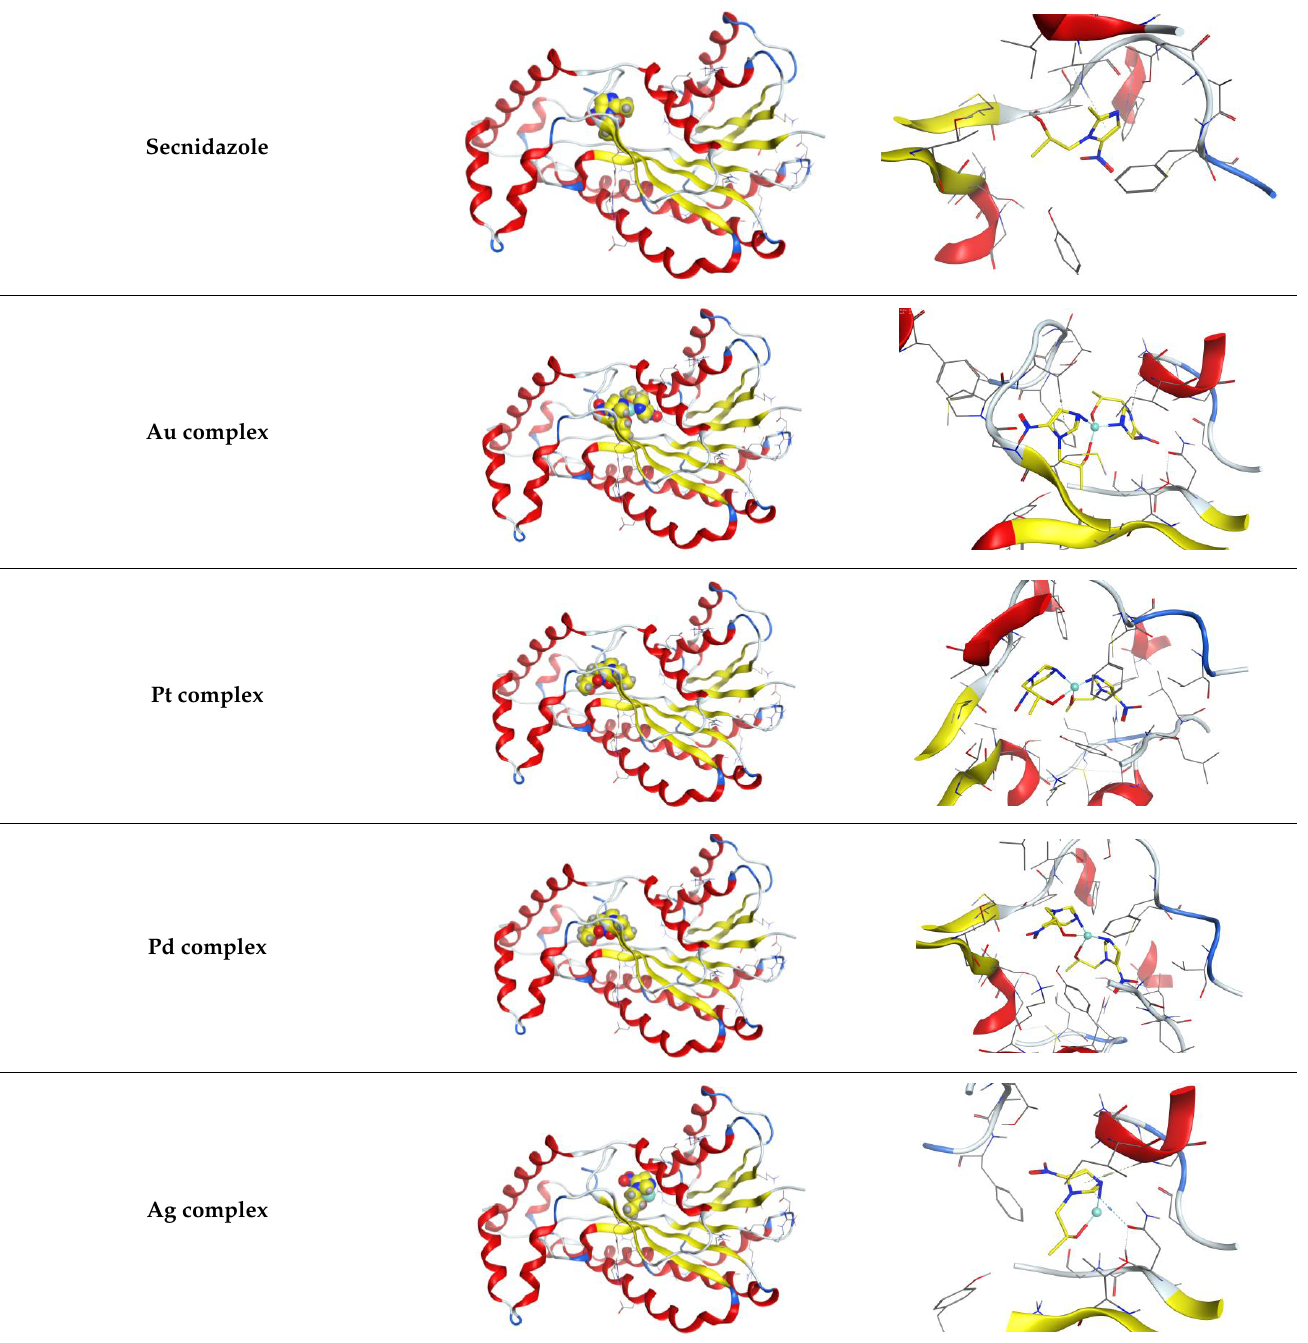
Table 14. Docking interaction of the ligand and its metal complexes with 3hb5 protein.